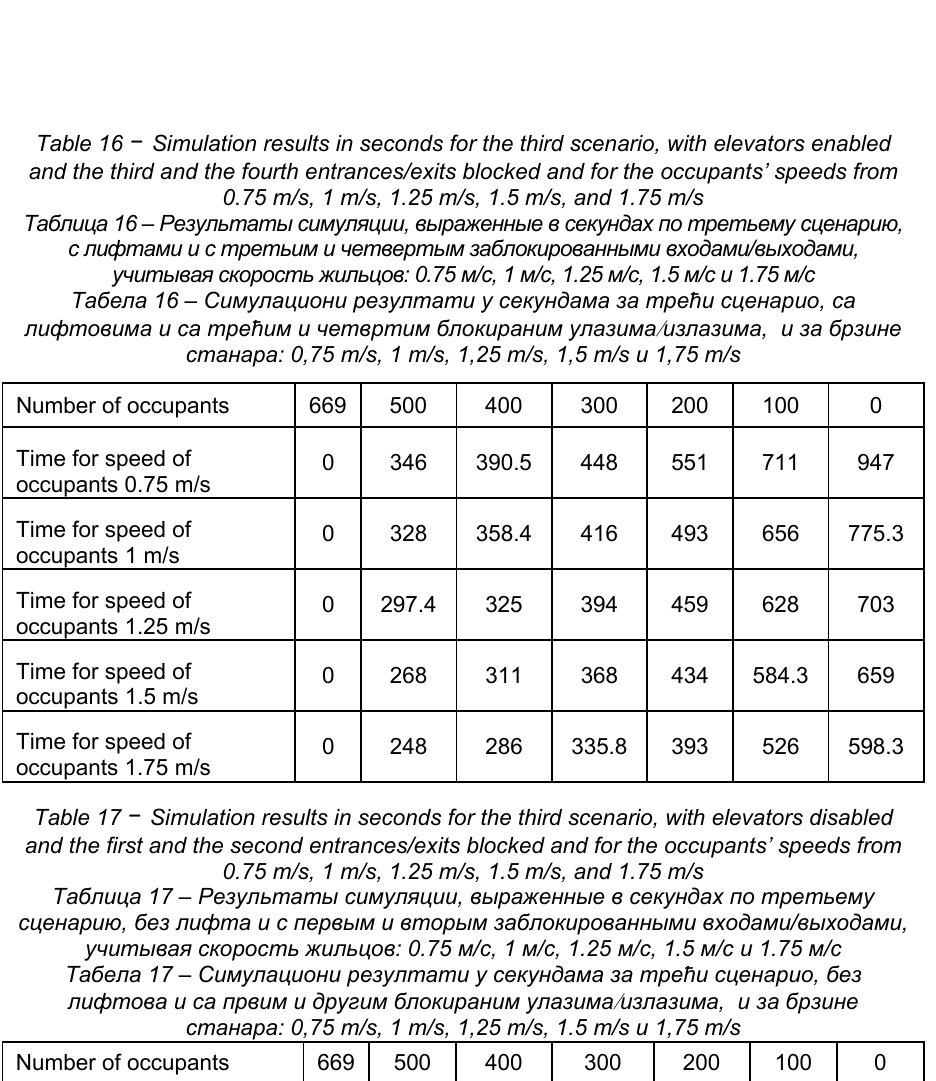
Table 16 – Simulation results in seconds for the third scenario, with elevators enabled and the third and the fourth entrances/exits blocked and for the occupants’ speeds from